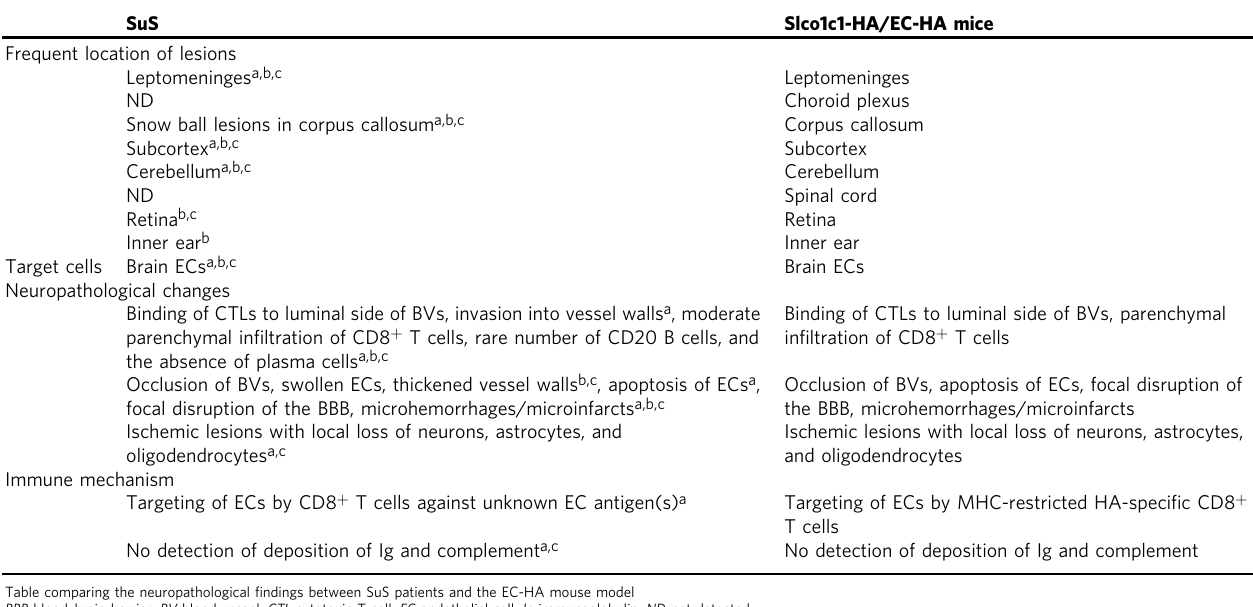
Table 2 Neuropathological evaluation of SuS patients and Slco1c1-HA/EC-HA mice.